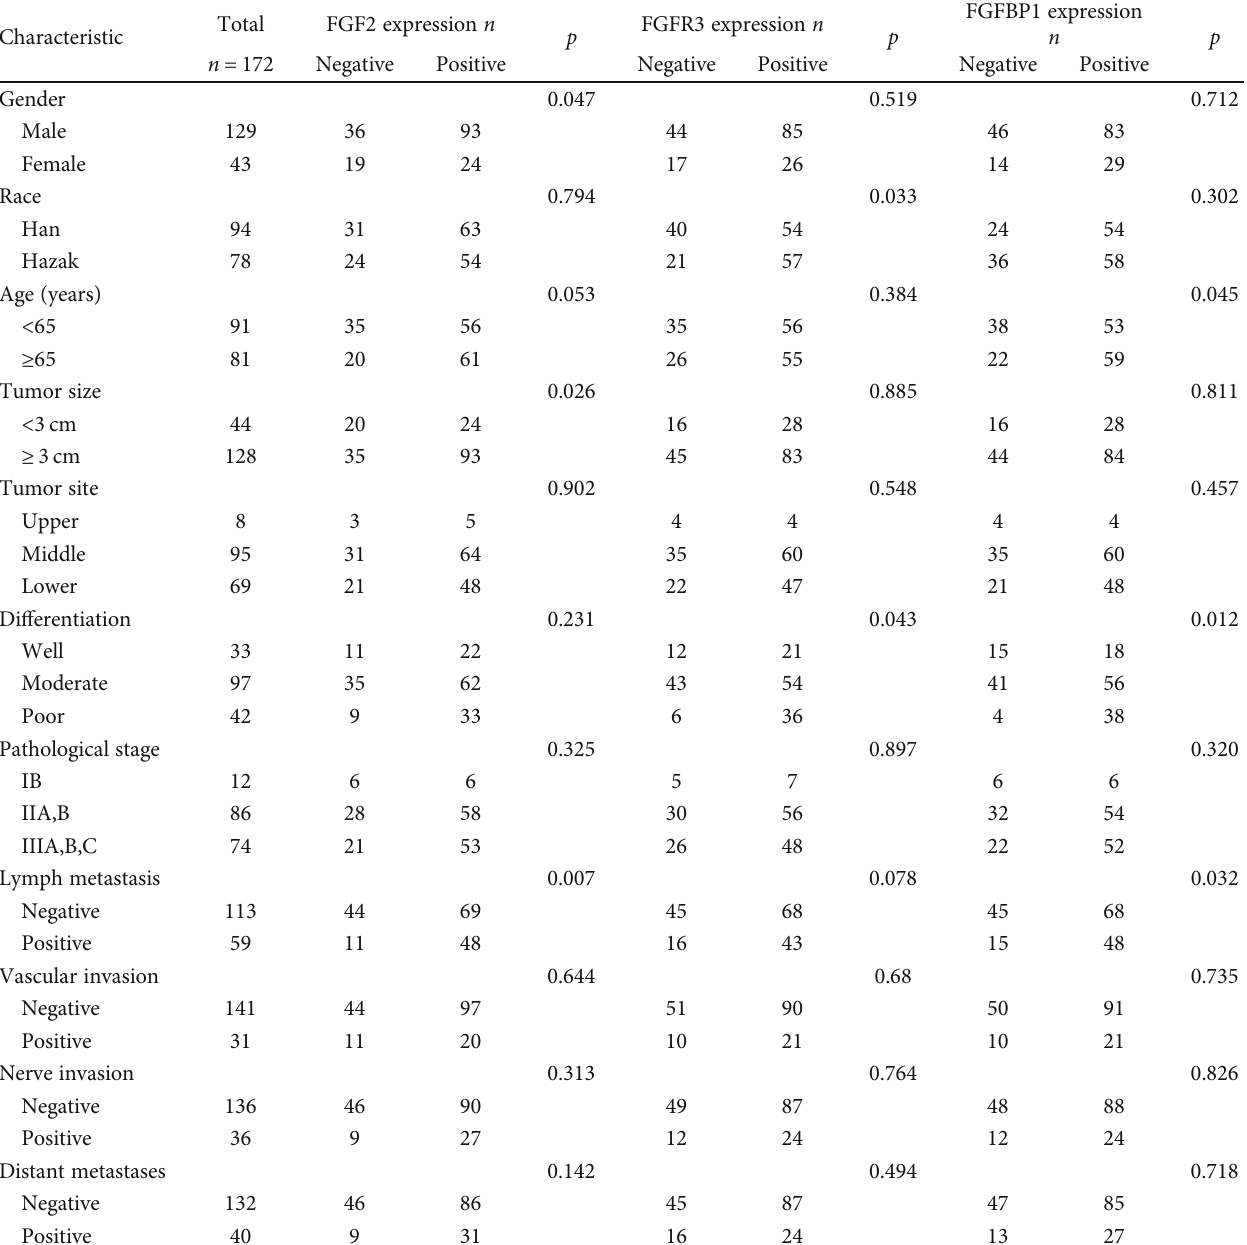
Table 3: Relationship between expression of FGF2, FGFR3, and FGFBP1 in ESCC and clinicopathological parameters ( n ).